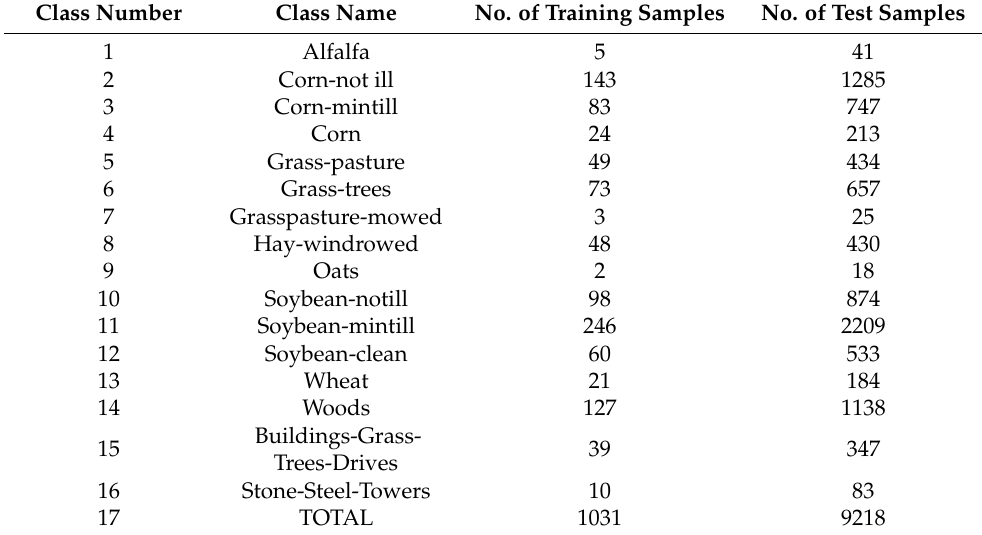
Table 1. Training and test samples of Indian Pines dataset.